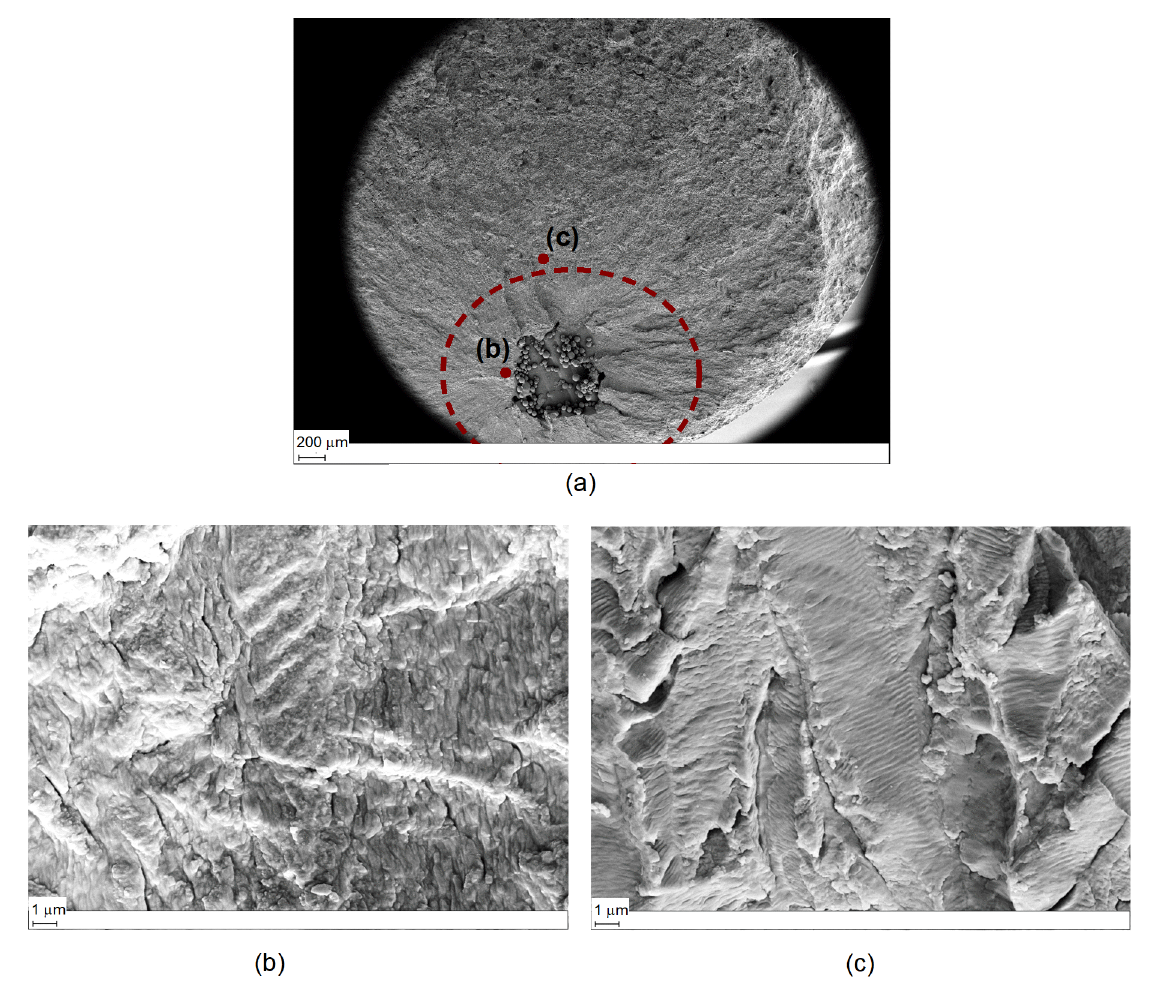
Figure 13. ( a ) SEM picture from failure surface of a Ti6Al4V coupon; ( b ) fracture surface near the artificial defect in the region around ∆ K = 12 MPa defect in the region around ∆ K = 25 MPa